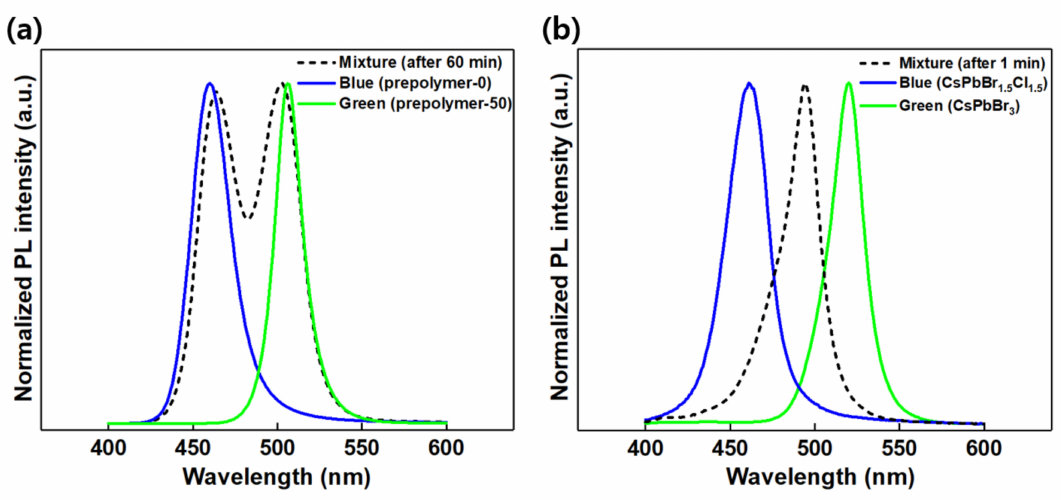
Figure 5. PL spectra for the color mixing tests of ( a ) prepolymer-0 (blue), prepolymer-50 (green), and a mixture of their solutions and ( b ) CsPbBr 1.5 Cl 1.5 (blue) and CsPbBr 3 (green) from the toluene anti-solvent and a mixture of their